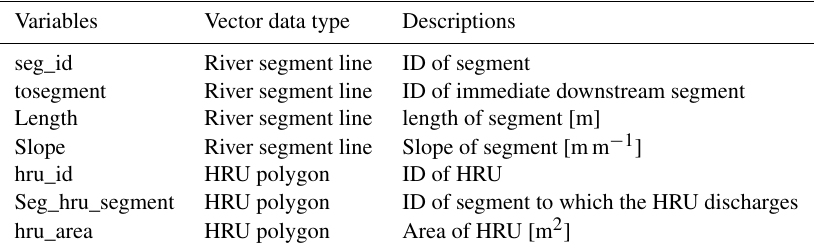
Table 2. River network information required in mizuRoute.